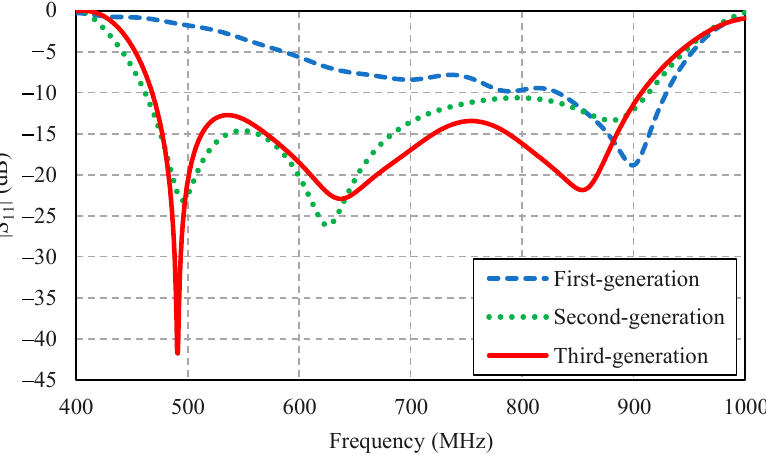
Figure 9. Simulated antenna gains of the first-, second-, and third-generation antenna schemes.